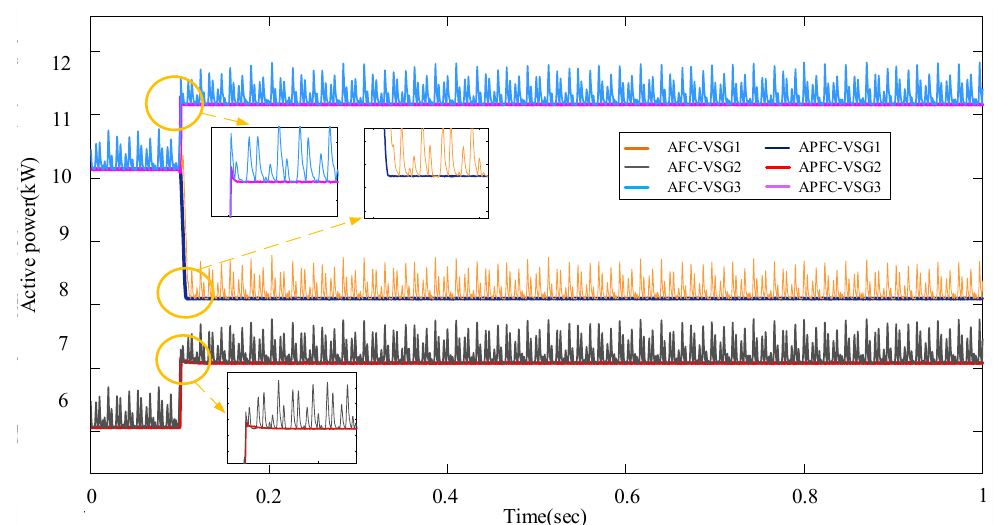
Figure 14. Active power regulation ability between the AFC-VSG and the APFC-VSG.